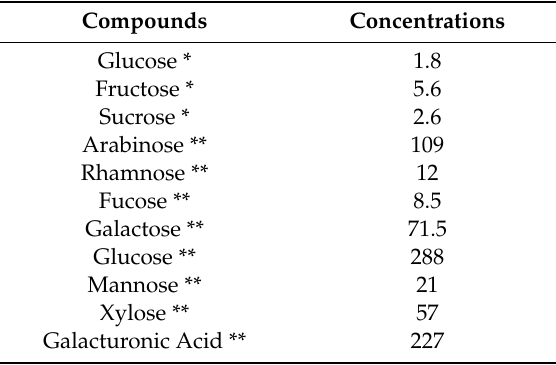
Table 2. Simple and parietal sugar contents of apple fruit [8,9].